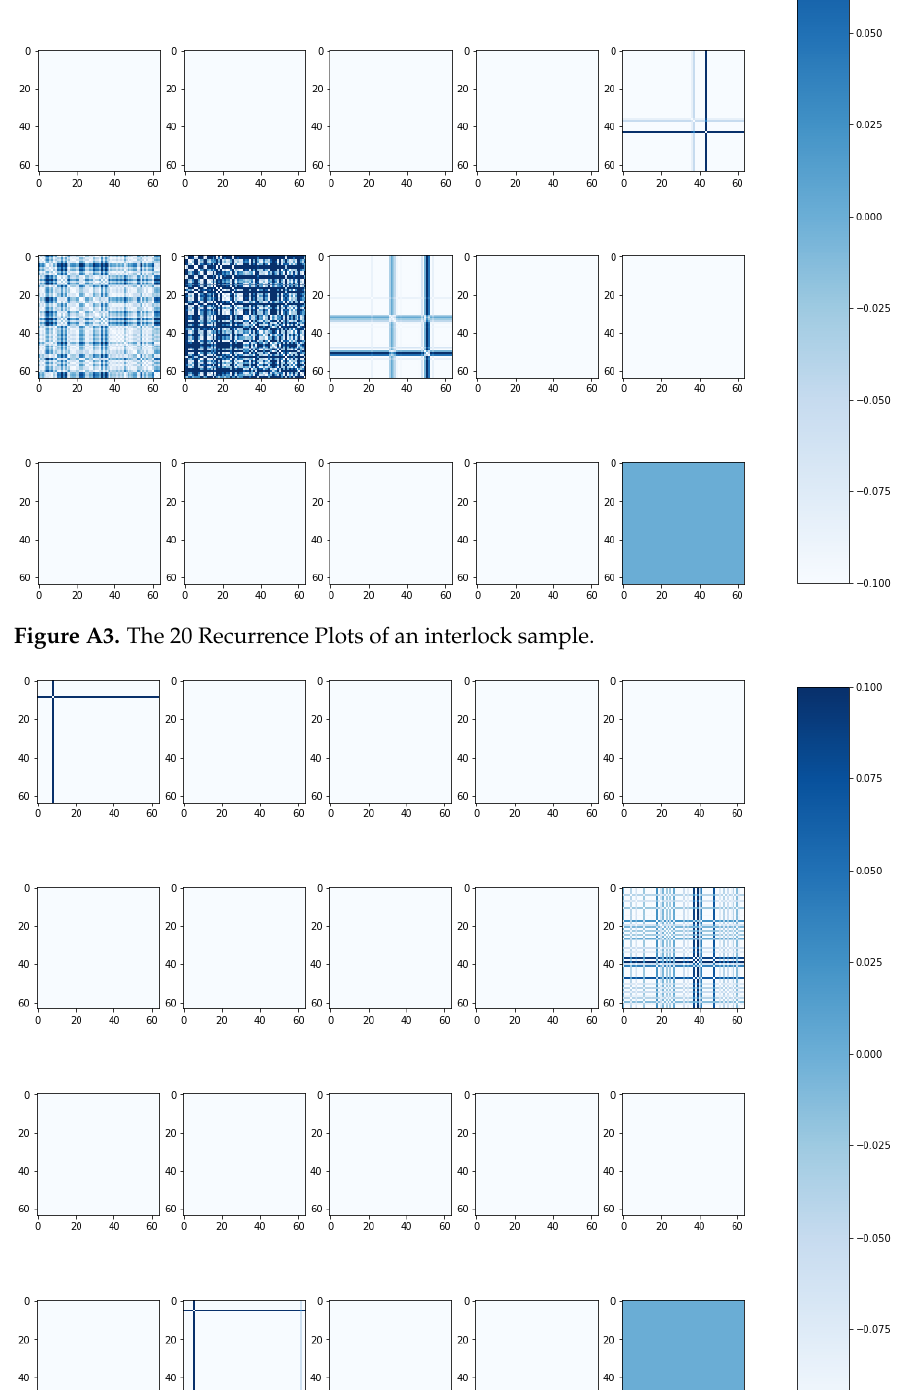
Figure A4. The 20 Recurrence Plots of a stable